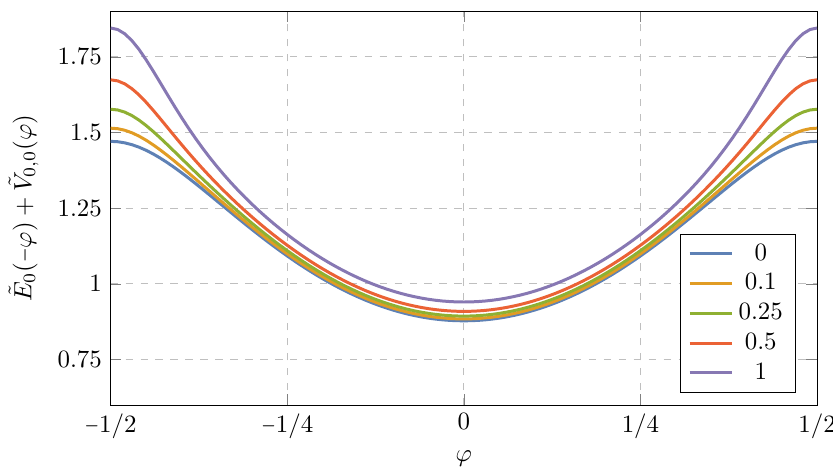
Figure 11. The corrected e(cid:11)ective potential (6.20) for q = 0 : 5 as a function of 4 = ( fg ) 2 , in units of ( (cid:25) ~ g ) 2 = 2. The blue (bottom) curve is the uncorrected e(cid:11)ective